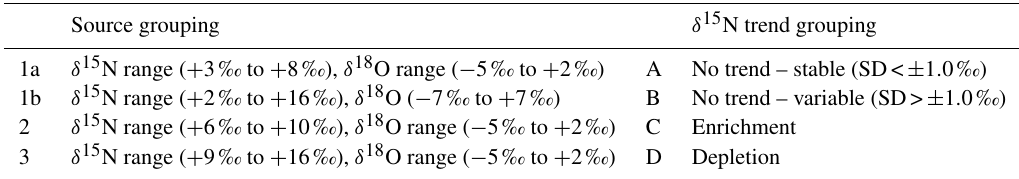
Figure 2. (a) Keeling plot of 1 / NO 3 ( x axis) vs. δ 15 N ( y axis). Three distinct groups are described as follows: (i) arrow represents the mixing line between fertilizer and enriched manure endmembers, (ii) (bottom) wide range NO 3 (mineral fertilizer leachate and soil N), and (iii) (middle group) manure–fertilizer mixture. δ 15 N reference sources (Wassenaar, 1995; Loo et al., 2017). (b) δ 15 N vs. nitrate Bayesian clustering model suggests five distinct groupings. Table 3. Nitrate isotopic distribution and trend grouping